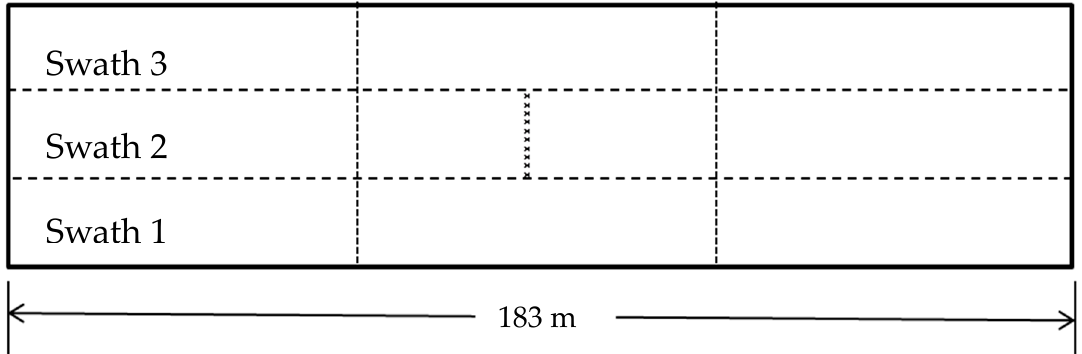
Figure 4. Three swath passes were sprayed for 183 m in each plot within each replication and treatment. Ten sampling stations were established in the middle of the 2nd swath.